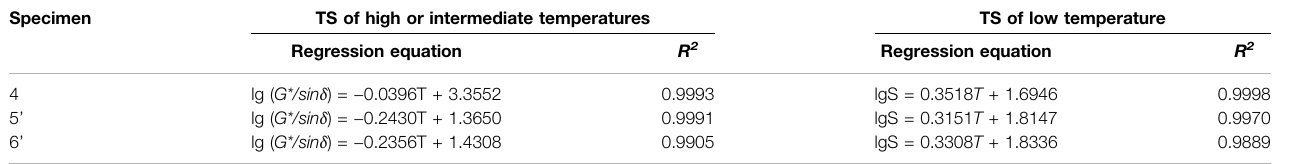
TABLE 6 | Linear equation regression analysis. Specimen TS of high or intermediate